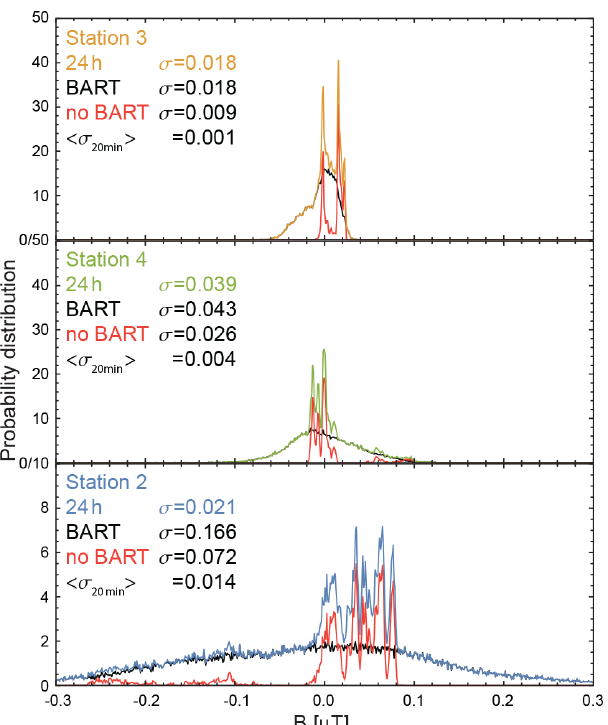
Figure 6. Time–frequency analysis of scalar magnetic field. Con- tinuous wavelet transform power spectral densities (µT 2 / Hz) for stations 3 (a) and 4 (b) . The spectrograms reveal power in several bands, including the 0.83mHz frequency corresponding to a 20min train period, common to both sensors. White dashed lines show the frequency range of a brick-wall filter (0.7–10mHz) applied to iso- late these narrowband features. Black lines show the region where edge effects may impact the wavelet transform, frequently called the cone of